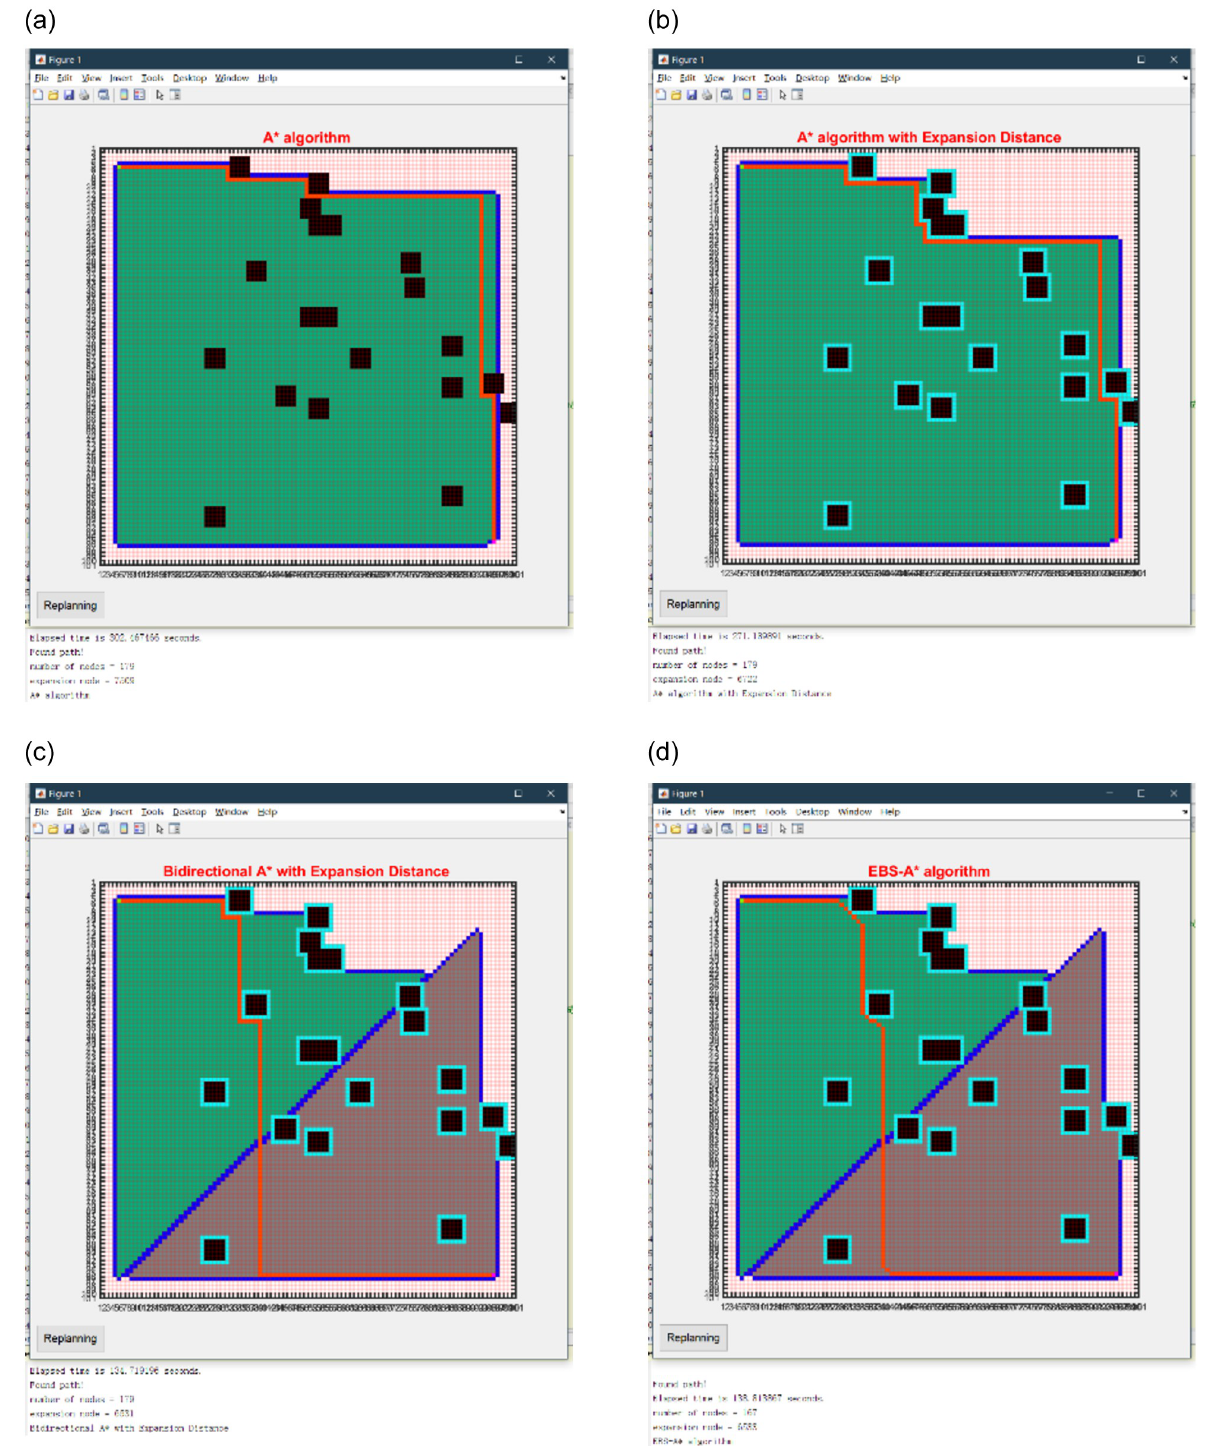
Fig 8. Simulation results of four algorithms on a 100 × 100 map. (a) A � algorithm. (b) A � with expansion distance. (c) Bidirectional A � with expansion distance. (d) EBS-A � algorithm.